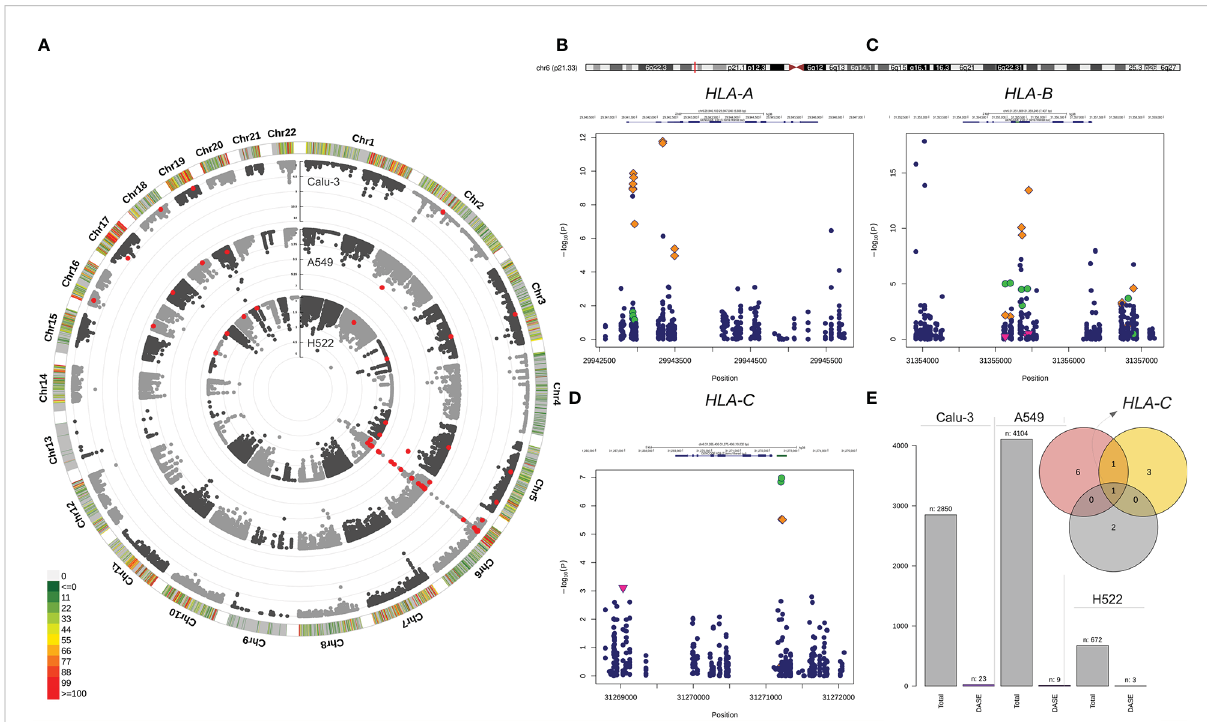
FIGURE 1 Differential allele-speci fi c expression sites across the single-nucleotide variants identi fi ed in Calu-3, A549, and H522 lung cell lines. (A) Circular Manhattan plot of the chromosomal distribution of eSNVs tested using a binomial approach. The densities of eSNVs per chromosome in the Calu-3, A549, and H522 cell lines are depicted inward. Red points represent DASE sites with FDR < 10%. (B – D) Regional plot of classical MHC class I genes with the orange diamond showing the DASE sites in Calu-3, green circles for A549, and H522 represented by the pink triangle point down. (E) The total number of eSNV sites tested in each lung cell line, followed by the number of DASE sites found. The intersection between the genes harboring DASE sites in the three cell lines is depicted in the Venn diagram. HLA-C was the only gene that showed DASE sites in all lines. Nevertheless, HLA-B was also shared between Calu-3 (red circle) and A549 (yellow